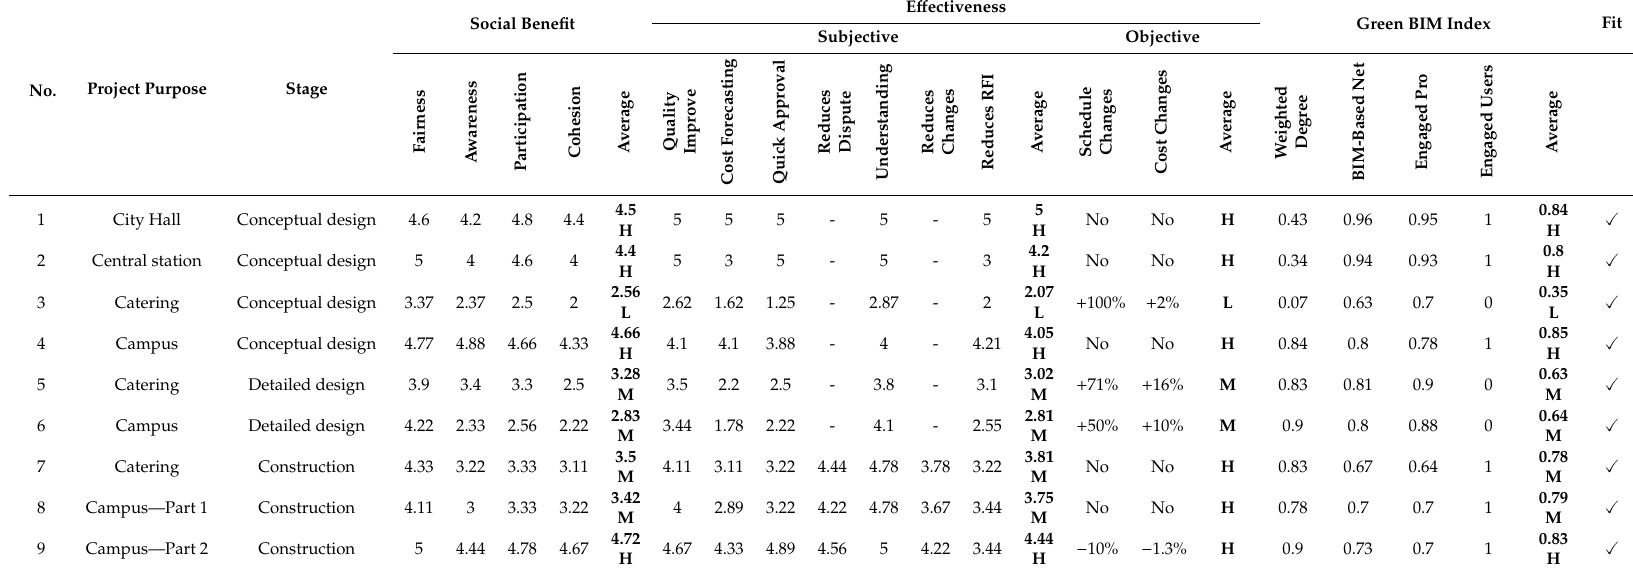
Table 5. Comparison of evaluations and index findings in the various projects